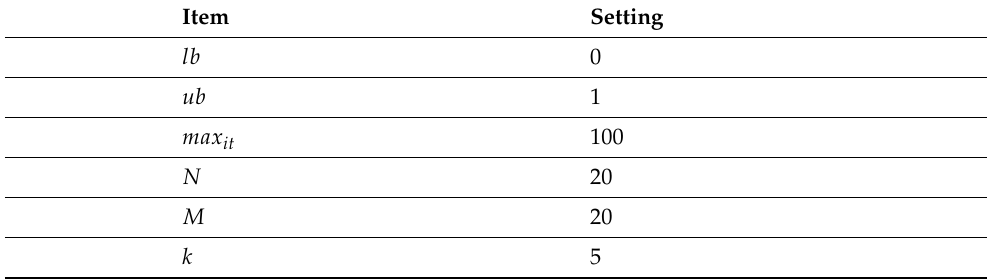
Table 3. Experimental runs’